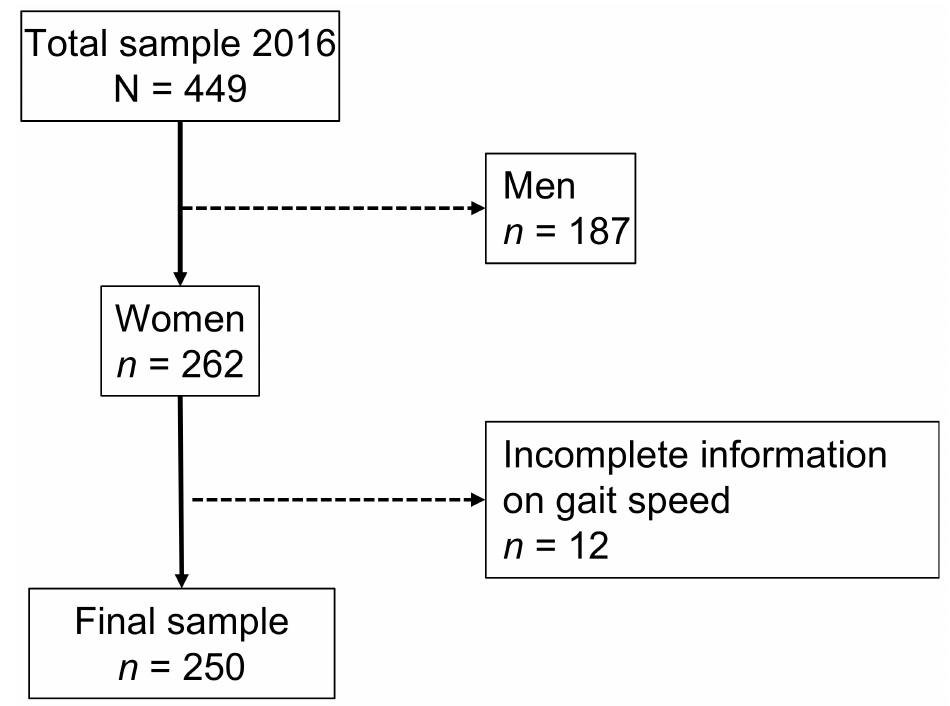
Figure 1. Sample size